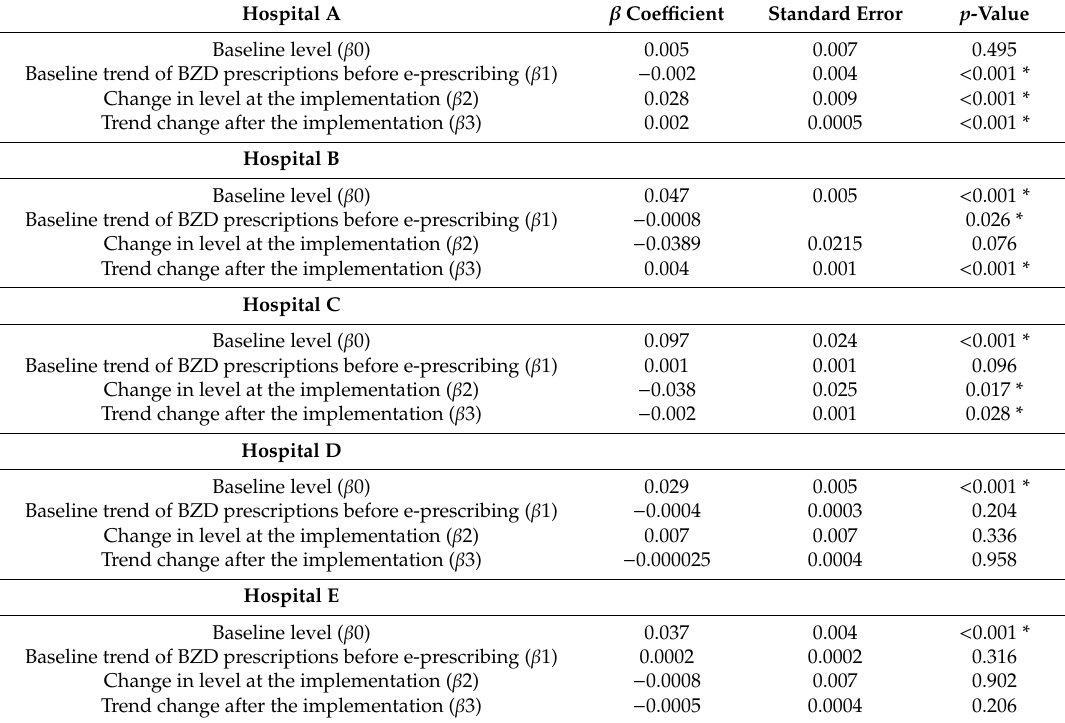
Table 2. Interrupted time-series regression analysis of new benzodiazepine prescriptions among hospitals in the